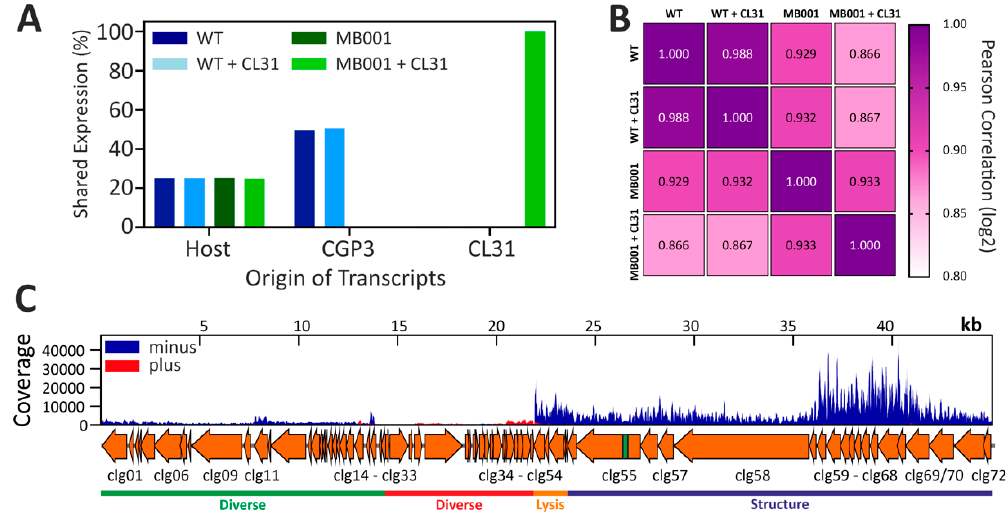
Figure 4. Transcriptome analysis of CL31-infected C. glutamicum strains. ( A ) The origin of transcripts is displayed as relative part of each sample. It was divided into transcripts from the host, from the CGP3 prophage element of the host or into transcripts from the CL31 phage. Bars represent mean values of two replicates. ( B ) Pearson correlation was calculated based on the Log2 of the TPM values of each experiment. ( C ) Transcription profile of the CL31 phage infecting C. glutamicum MB001. Bacterial cells and phages were mixed with an MOI of 0.1 and incubated in BHI medium at 30 °C and 120 rpm. The coverage shows one representative sample. A detailed sampling is shown in Figure S4 and detailed analysis is represented by Table S5.